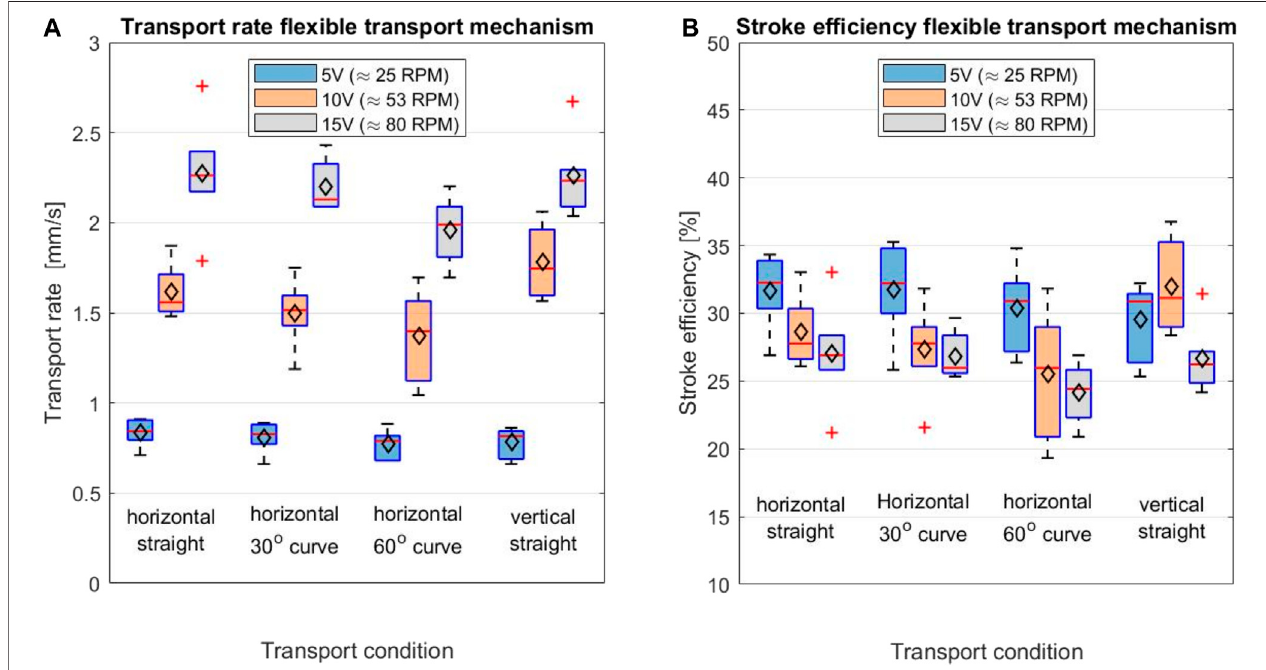
FIGURE 12 | Boxplot displaying (A) the transport rate [mm/s] and (B) the stroke ef fi ciency [%] for different test conditions; the shaft in horizontal orientation while being straight, in 30 ° and 60 ° curved positionand with theshaft in vertical orientation. The maximum and minimum values are indicated by theoutermost horizontalsolid lines on each of the boxplots. The median is indicated by the horizontal red line in each boxplot, while the mean is indicated by the black diamond.